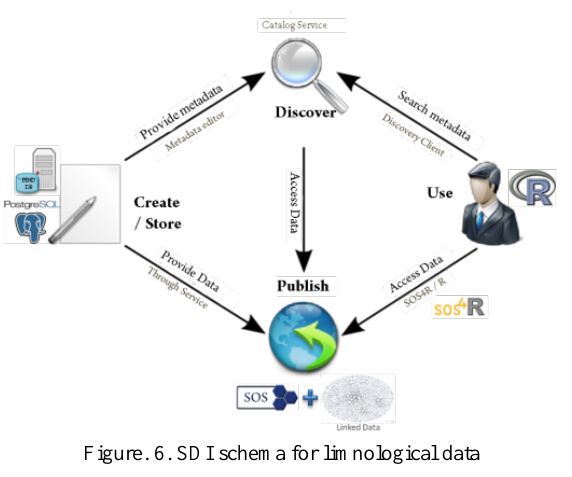
Figure. 6. SDI schema for limnological